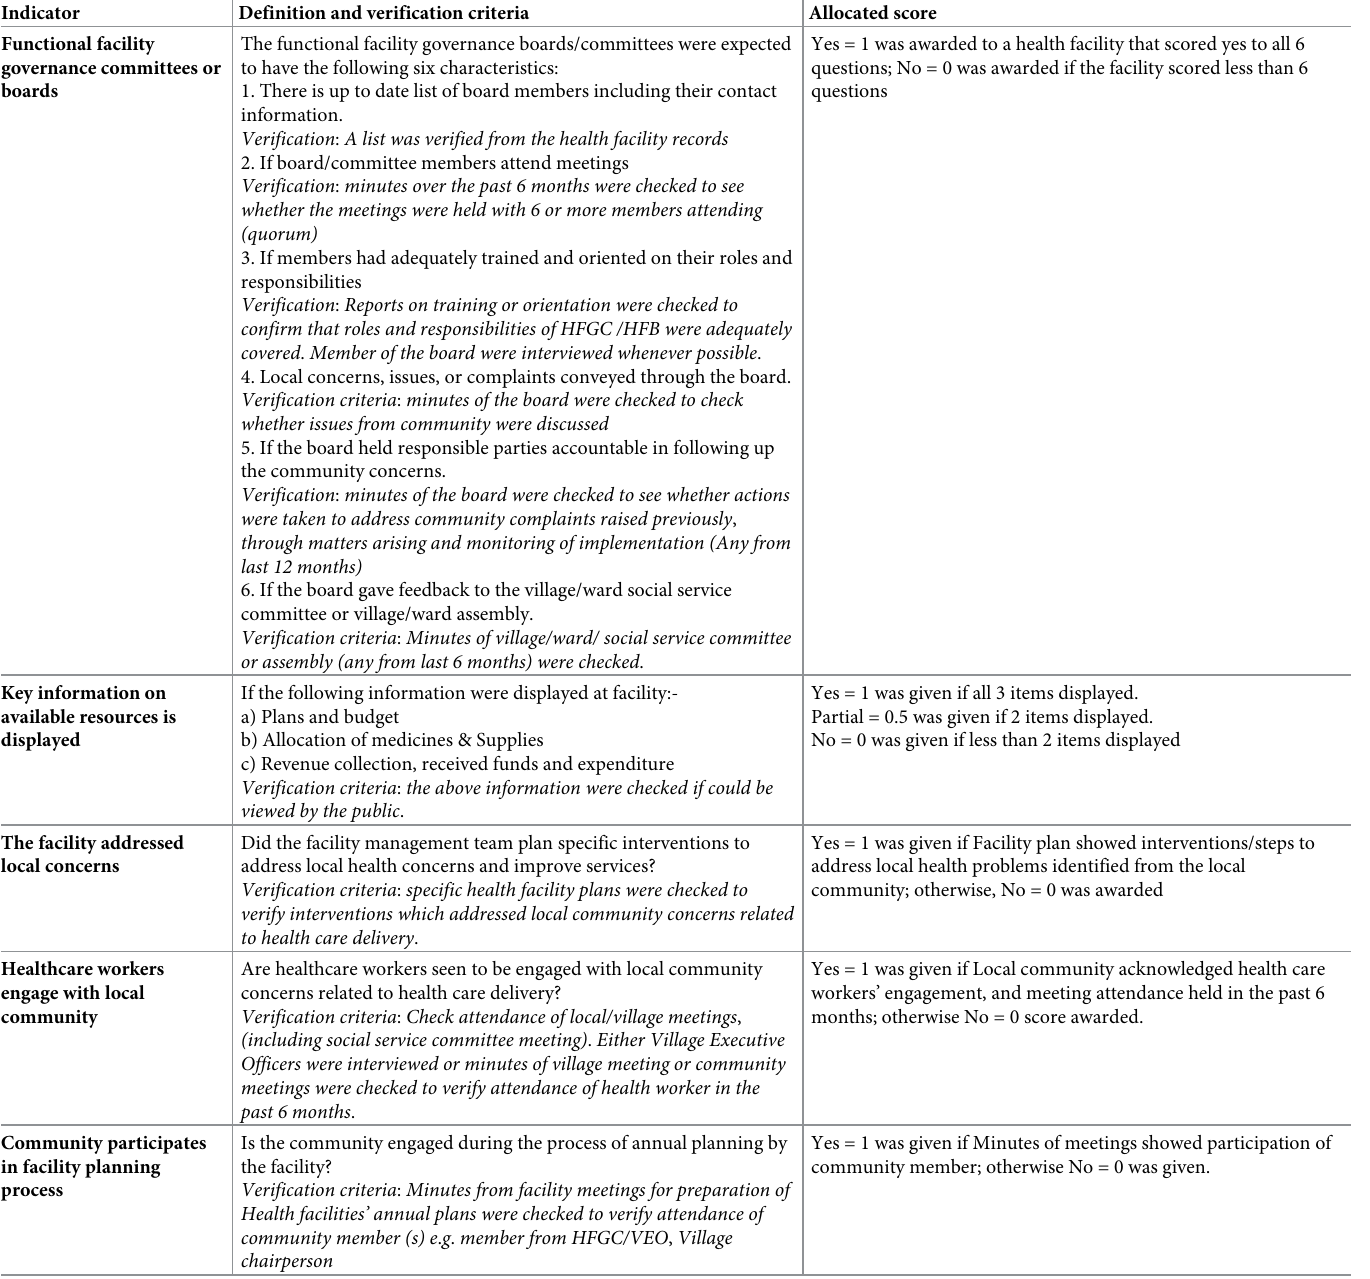
Table 1. A section on SRA tool assessing social accountability performance at healthcare facilities in